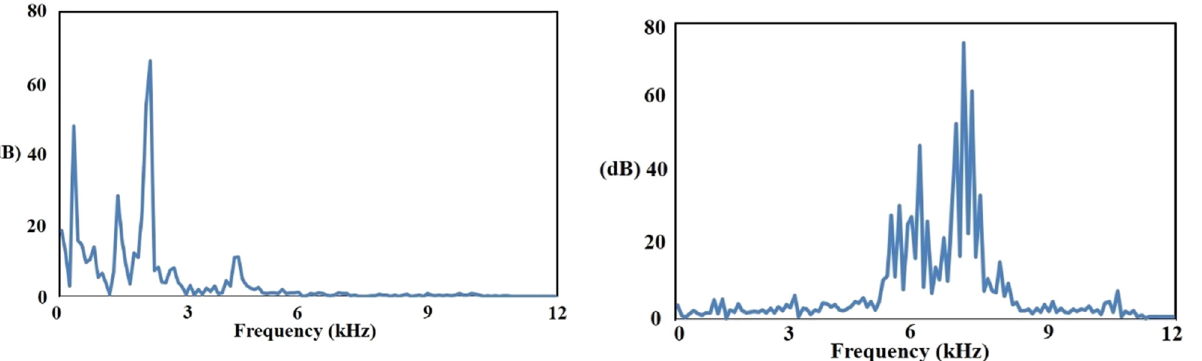
Figure 20: Frequency domain signal ( broken external race ) .